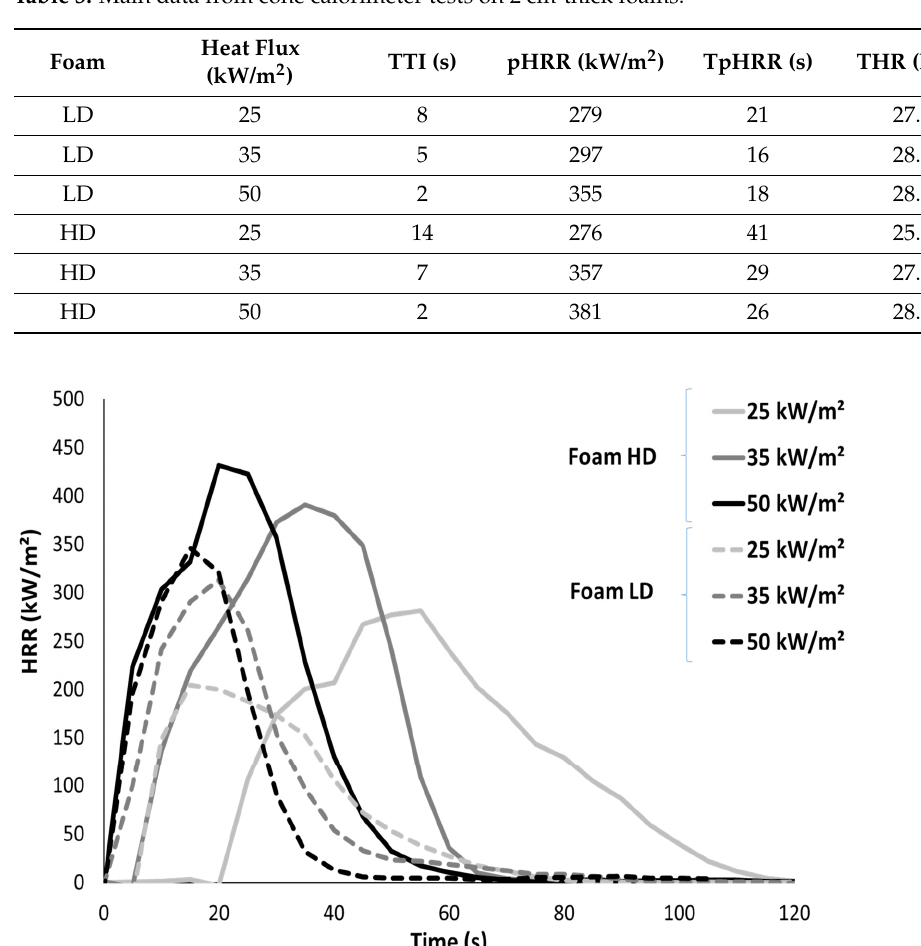
Figure 4. Heat release rate curves of both foams in cone calorimeter tests (sample thickness 2 cm).